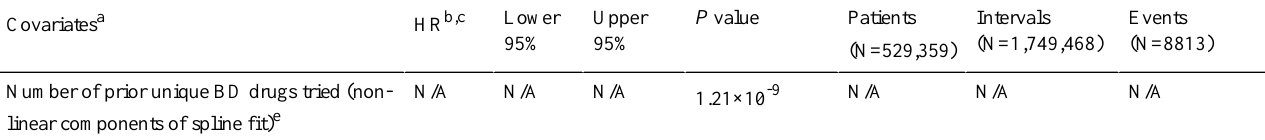
linear components of spline fit) e a Covariates labeled “prior” are related to the 1-year period before the index exposure. b Covariates are sorted by their hazard ratio value. c HR: hazard ratio. d SGA: second-generation antipsychotic. e Covariates with significant P values (<.05; no multiple testing correction). f SSRI: selective serotonin reuptake inhibitor. g FGA: first-generation antipsychotic. h MSA: mood stabilizing anticonvulsant. i SNRI: serotonin-norepinephrine reuptake inhibitor. j NDRI: norepinephrine-dopamine reuptake inhibitor (represented by bupropion only). k Polypharmacy 4: uncommon combination of four or more bipolar disorder drug classes. l NASSA: noradrenergic and specific serotonergic antidepressant (represented by mirtazapine only). m N/A: not applicable. n Polypharmacy 3: uncommon combination of three bipolar disorder drug classes. o Polypharmacy 2: uncommon combination of two bipolar disorder drug classes. p BD: bipolar